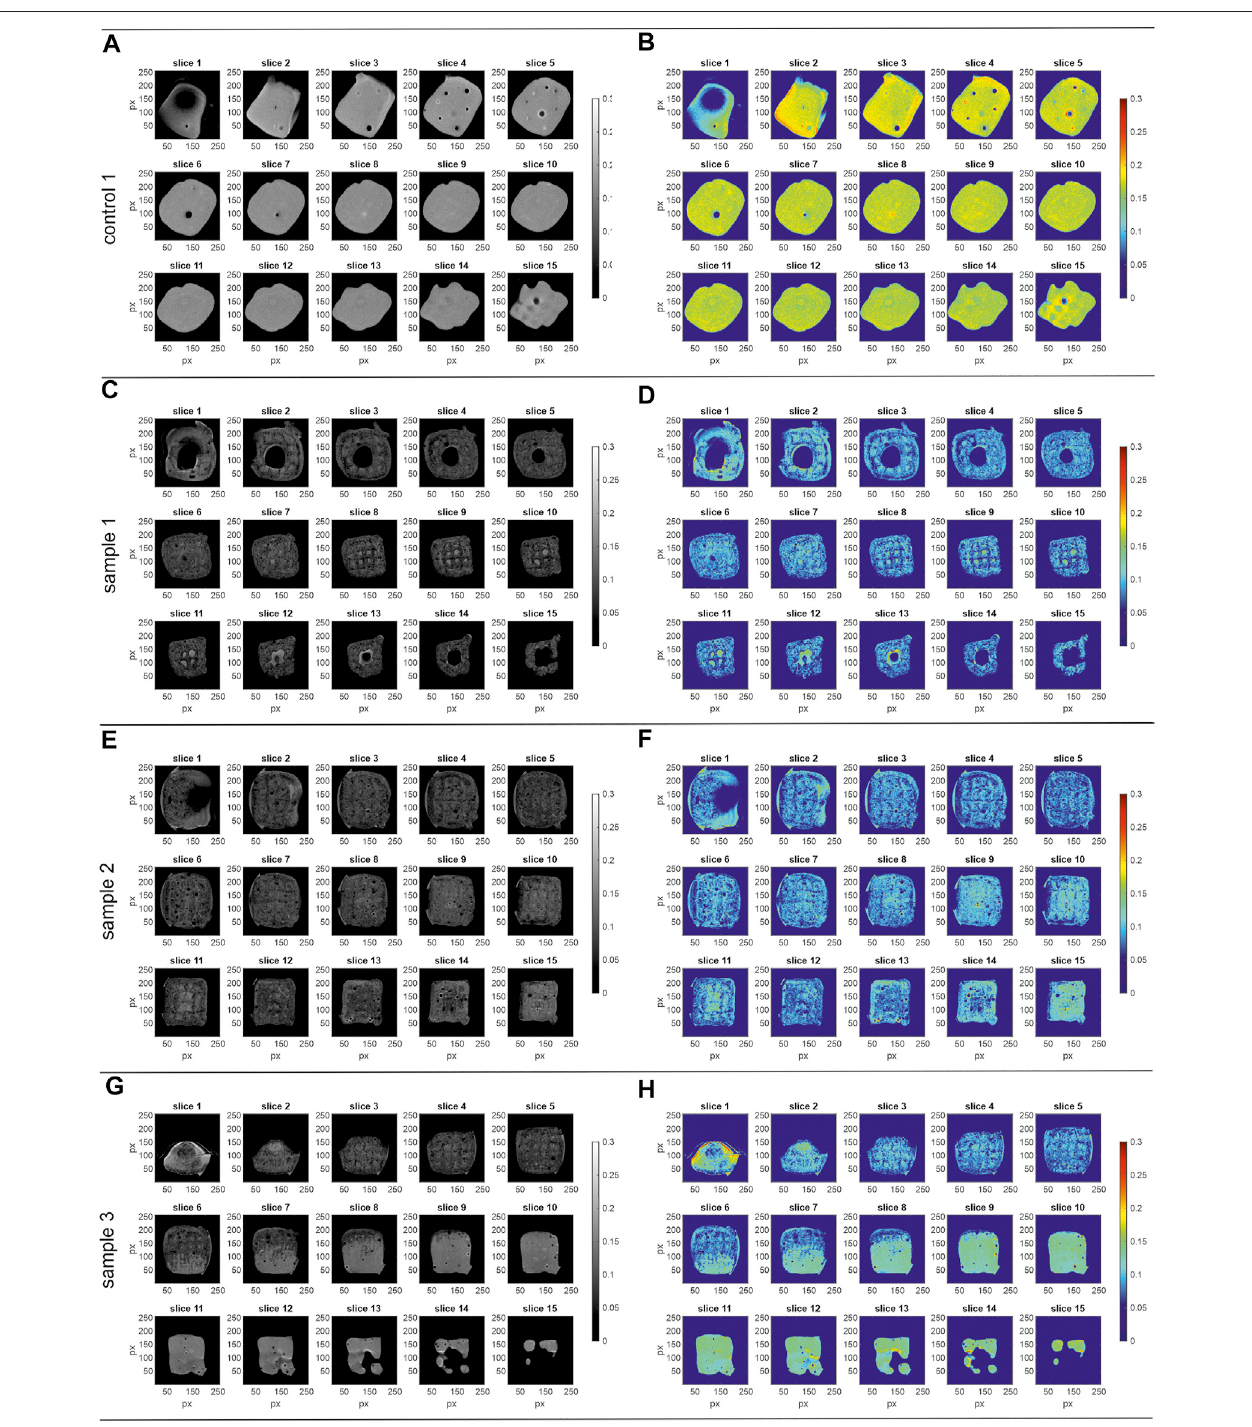
FIGURE 4 | MRI data of the process samples run 1. Shown are the images of the 15 axial slices (z-stack) with slice 1 as bottom and slice 15 as top slice (256 × 256 px). Left) grey scale, right) pseudo colour images (RGB; jet colour bar) (A,B) control 1, fi eld of view 12 mm 2 × 12 mm 2 (C,D) sample 1, fi eld of view 16 mm 2 × 16 mm 2 (E,F) sample2, fi eldofview16 mm 2 ×16 mm 2 (G,H) sample3, fi eldofview16 mm 2 ×16 mm 2 .Thecorrespondinghistogramsofthenormalizedpixelintensity are shown in Figure 3A